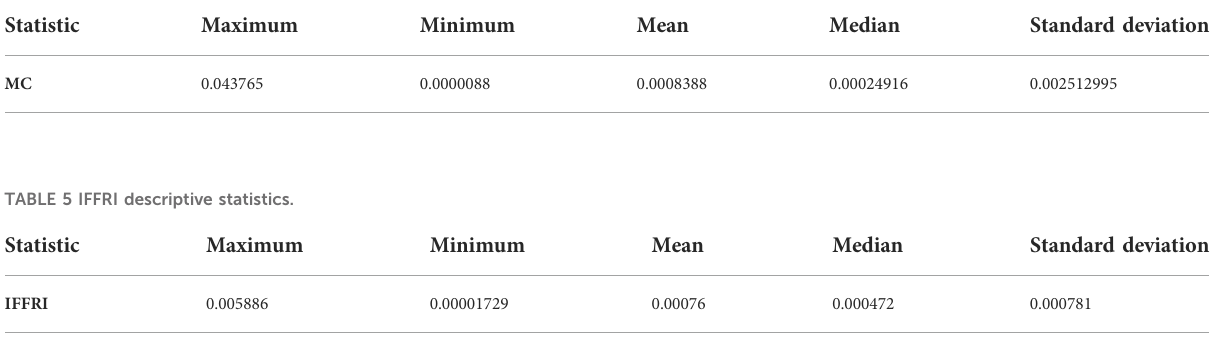
TABLE 4 MC descriptive statistics.